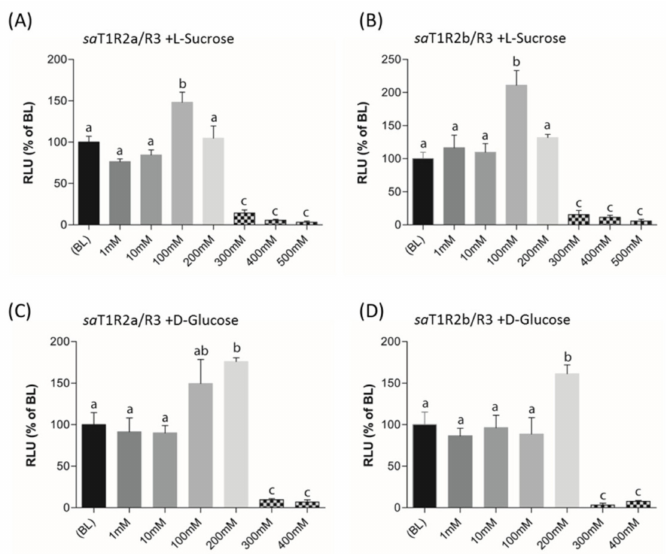
Figure 9. saT1R2a / R3 and saT1R2b / R3 heterodimer responses to L-Sucrose ( A , B ) and D-glucose ( C , D ) at di ff erent concentrations (1–500 mM). Evaluation of sugar responses was based on the RLU mean ± SEM of four independent determinations ( n = 4) normalized to the mean response of same transfections stimulated with reduced assay medium (BME + 1% FBS). BL (Basal Levels) = 100% RLU. Di ff erent lowercase letters (a,b,c) on top of bars indicate significant di ff erences ( p < 0.05) between concentrations, assessed by one-way ANOVA followed by Tukey’s Multiple Comparison Test (GraphPad Prism version